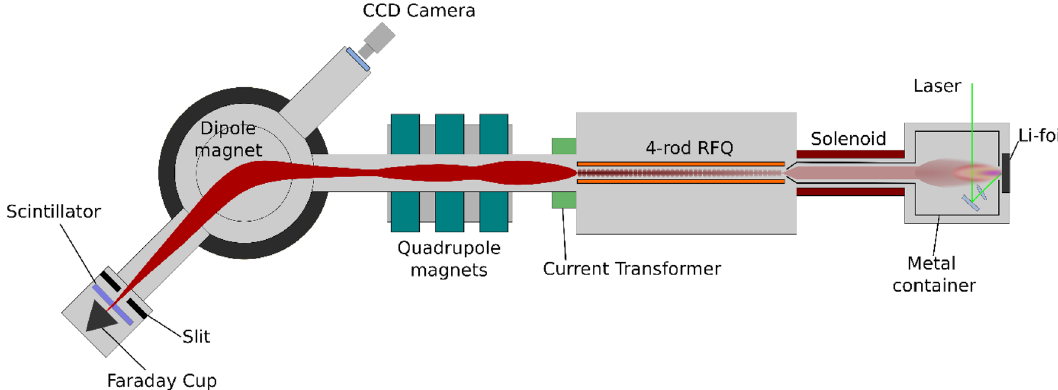
Figure 2. Overview of the experimental apparatus used for beam analysis of the accelerated lithium beams (illustrated by Inkscape, 1.0.2, https:// inksc ape. org/). From right to left, a laser ablation plasma is produced in the laser-target interaction chamber and is transported toward the RFQ linac. When entering the RFQ linac, the ions are separated from the plasma and injected into the RFQ linac by an abrupt electric field generated by a 52 kV voltage difference between the drift region extraction electrode and the RFQ electrodes. The extracted ions are accelerated from 22 to 204 keV/n while guided by the 2-m-long RFQ electrodes. A current transformer (CT), installed at the exit of the RFQ linac, provides a non-destructive measurement of the ion beam current. The beam is focused by three quadrupole magnets and guided to a dipole magnet that is used to select the Li 3+ beam and bend it into a detector. Behind a slit, a retractable plastic scintillator and a Faraday cup (FC) biased to -400 V are used to detect the accelerated